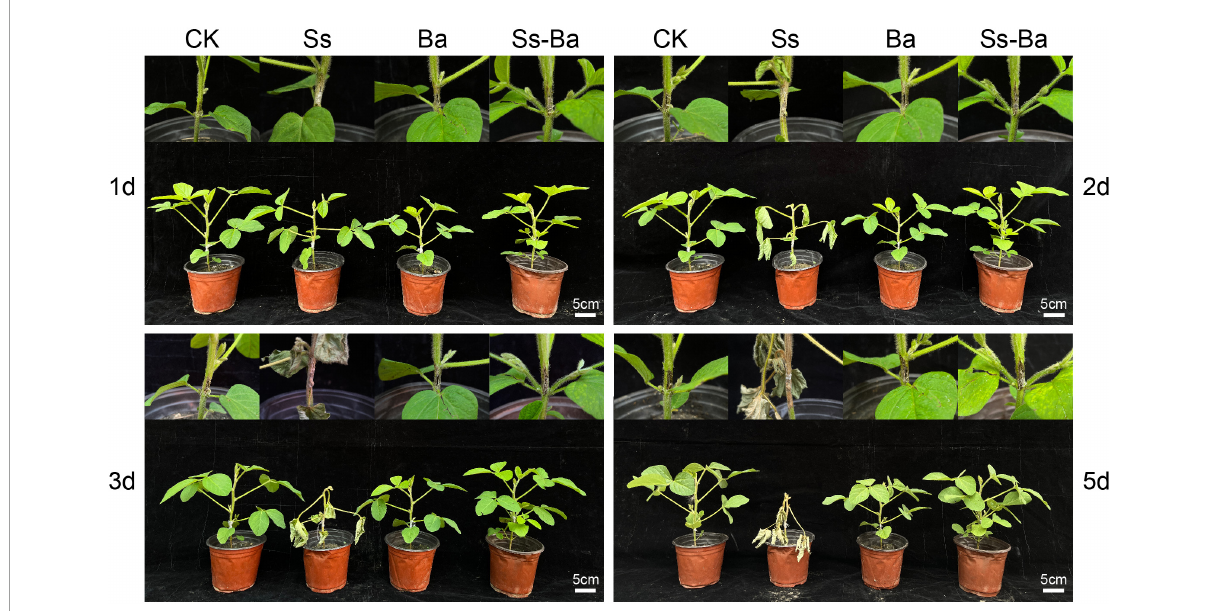
FIGURE1 Potted G. max seedling inoculated with B. amyloliquefaciens , S. sclerotiorum , and their mixture. Ba, Ss, and Ss-Ba indicated that the stem of soybean seedling was inoculated with B. amyloliquefaciens , S. sclerotiorum , and both microorganisms, respectively. Ck, scratch treatments. The words of 1, 2, 3, and 5 d on the left and right of the picture indicate the days after